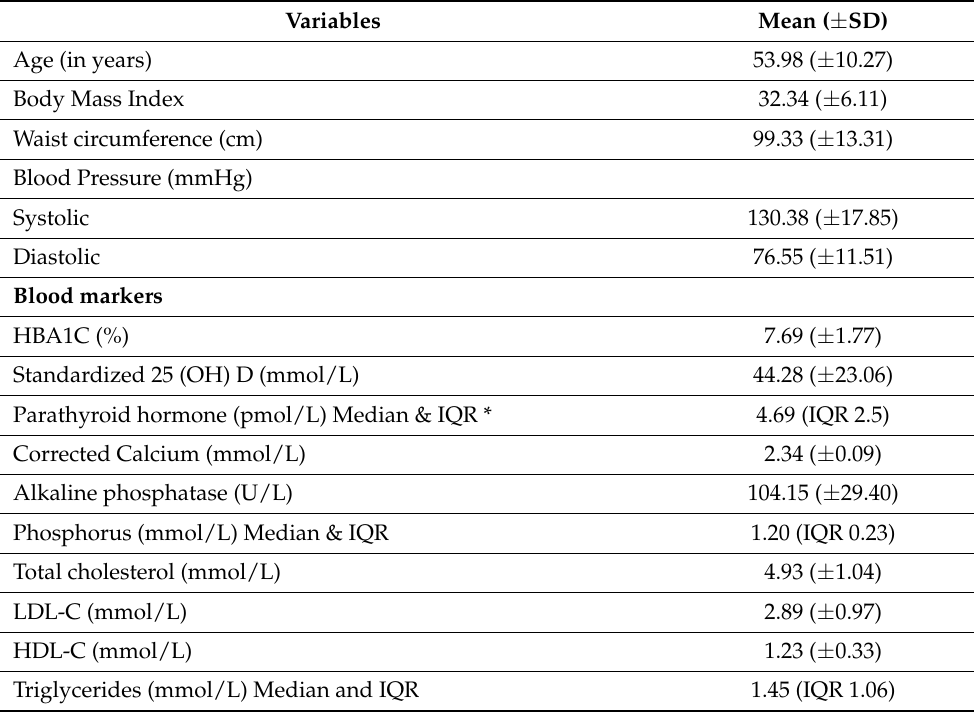
Table 1. Mean (standard deviation) for age, anthropometric and blood markers for patients with diabetes in Riyadh, Saudi